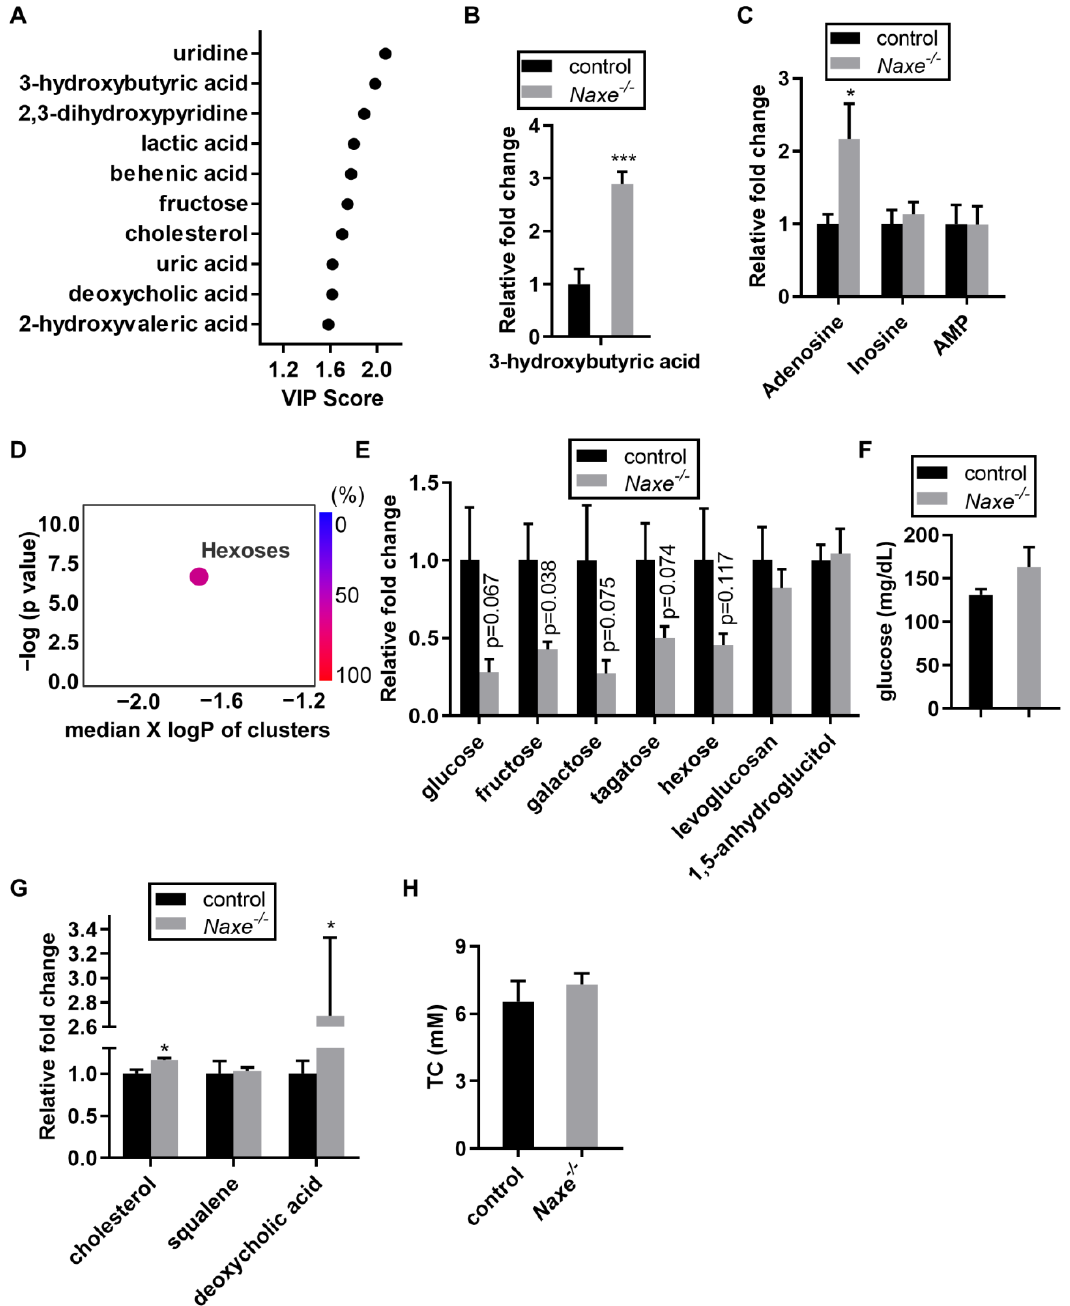
Figure 1. Untargeted profiling identified important metabolites associated with NAXE functions. ( A ) Top 10 VIP metabolites that may be associated with NAXE functions. ( B ) The relative abundance of ketone body 3-hydroxybutyric acid and ( C ) adenosine-associated metabolites in control and NAXE knockouts. ( D ) ChemRICH set-enrichment statistics plot shows enrichment of hexose cluster metabolites associated with NAXE function in the heart. Each node reflects a significantly altered cluster of metabolites. Enrichment p -values are given by the Kolmogorov–Smirnov test. Node sizes represent the total number of metabolites in each cluster set. The node color scale shows the scale of metabolite changes in NAXE knockout compared with WT control samples. ( E ), The relative abundance of seven components of the hexose cluster. ( F ), Plasma glucose measurement. ( G ), Relative cholesterol, squalene, and deoxycholic acid abundance in control and NAXE knockout mice. ( H ), Total cholesterol (TC) measurement in the plasma of control or NAXE knockout mice. * p < 0.05; *** p < 0.001; n = 6 mice per